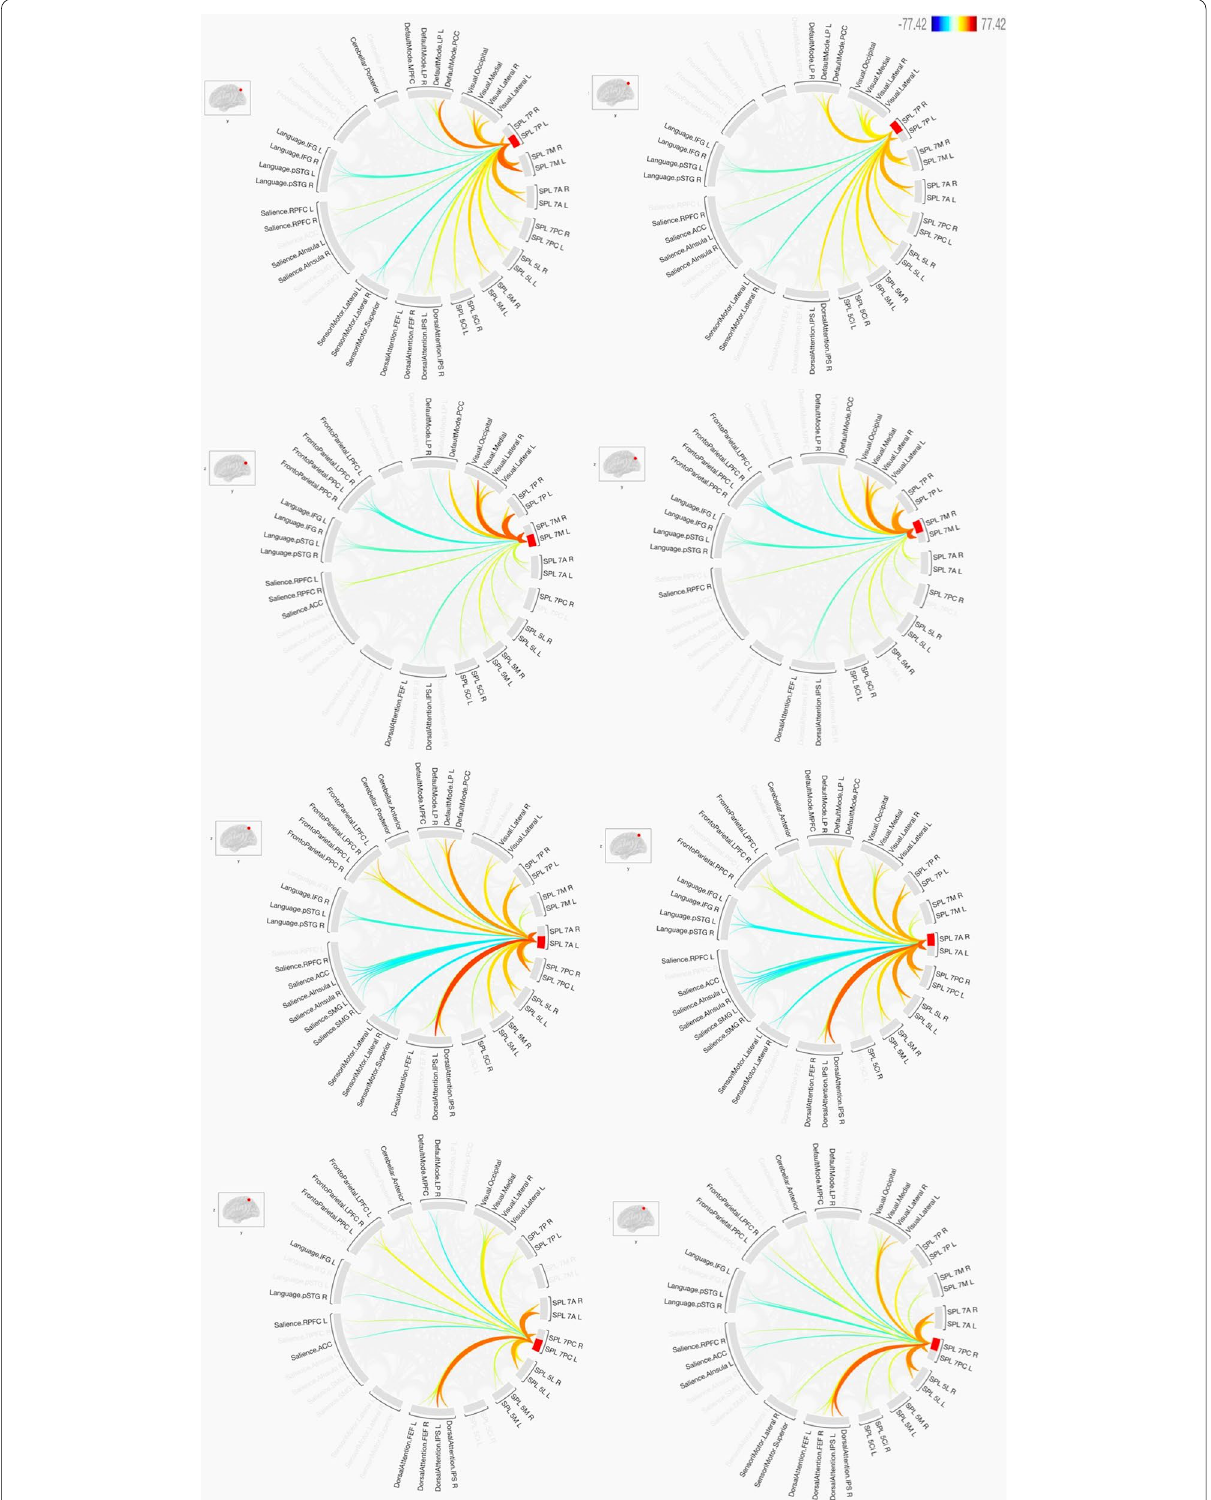
Fig. 4 The functional connectivity of the four SPL sub-regions of BA 7 in both hemispheres is shown here. The lines of the connections in red indicate positive connectivity while blue indicates negative connectivity. The colours of the lines are proportional to statistical strength, and the T-bar is shown in the top right-hand